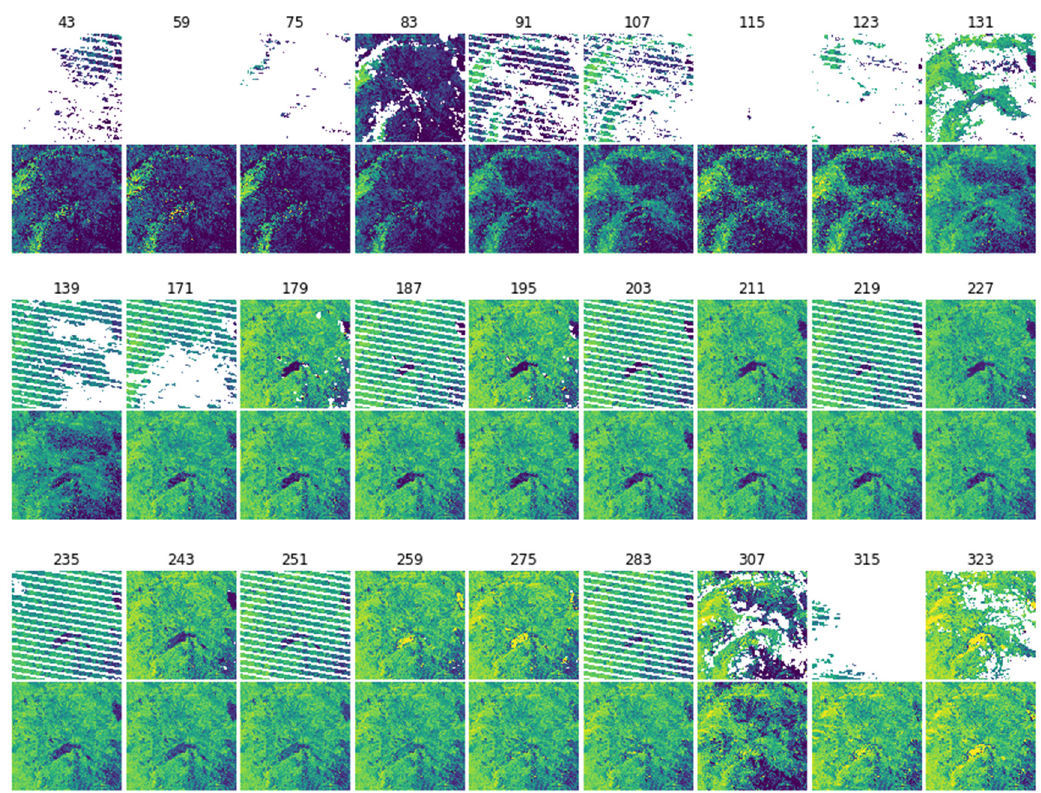
Figure 9. NDVI visual results of SIM (the upper image of each pair is the input and the lower image is the output) at the NRM area for all input days. The blanks and gaps in the upper images in each pair result from the removal of clouds, cloud shadows, and scan line corrector failure.